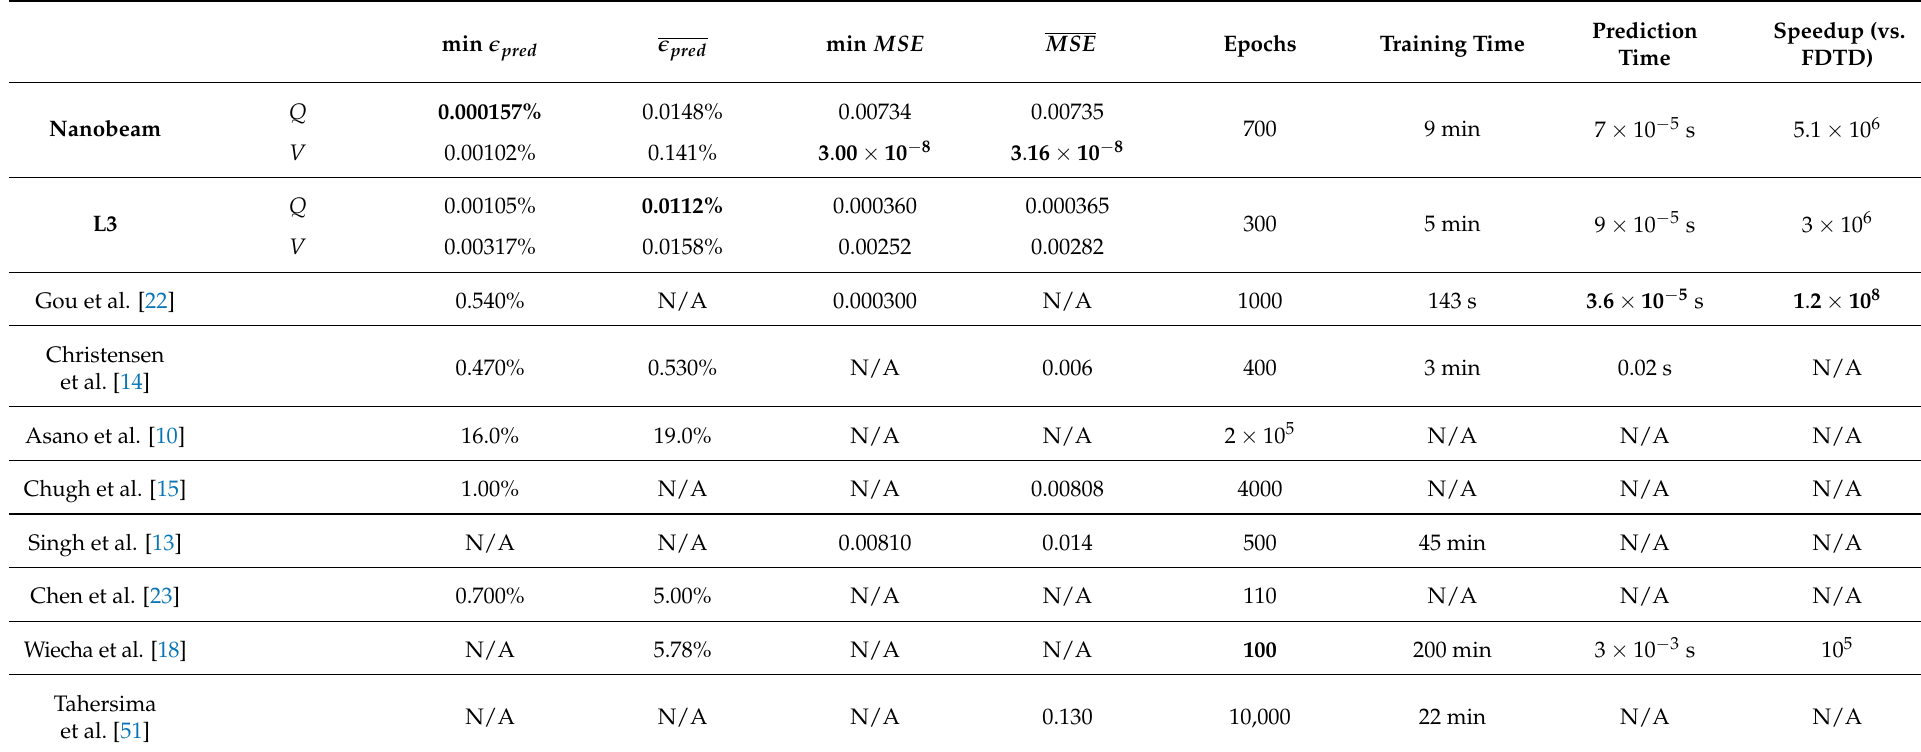
Table 3. Results of training LRS-RCNN with nanobeam and L3 nanocavity. Tabulated are the performance metrics of the predictor at the test/validation phase and its comparison against prior works. Data partially extracted from Figures 6 and 8. Overlined parameters, such as (cid:101) pred and MSE , indicate converged values. Bold-faced numbers are best metrics. Prediction time and speedup vs. FDTD, both calculated by averaging the time measured with samples in the validation dataset, refer to the time for characterizing a single structure by LRS-RCNN. N/A means no data available from the cited